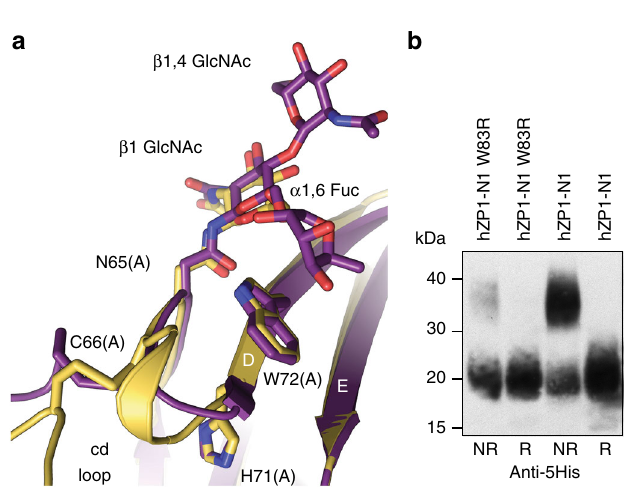
Fig. 7 ZP1 mutation W83R affects secretion and homodimerisation of hZP1- N1. a W72 stacks between the cd loop and the N65 glycan α 1,6 fucose. b Anti-5His immunoblot of hZP1-N1 W83R mutant (20 μ L medium) compared with wild-type (10 μ L medium) 72 h post